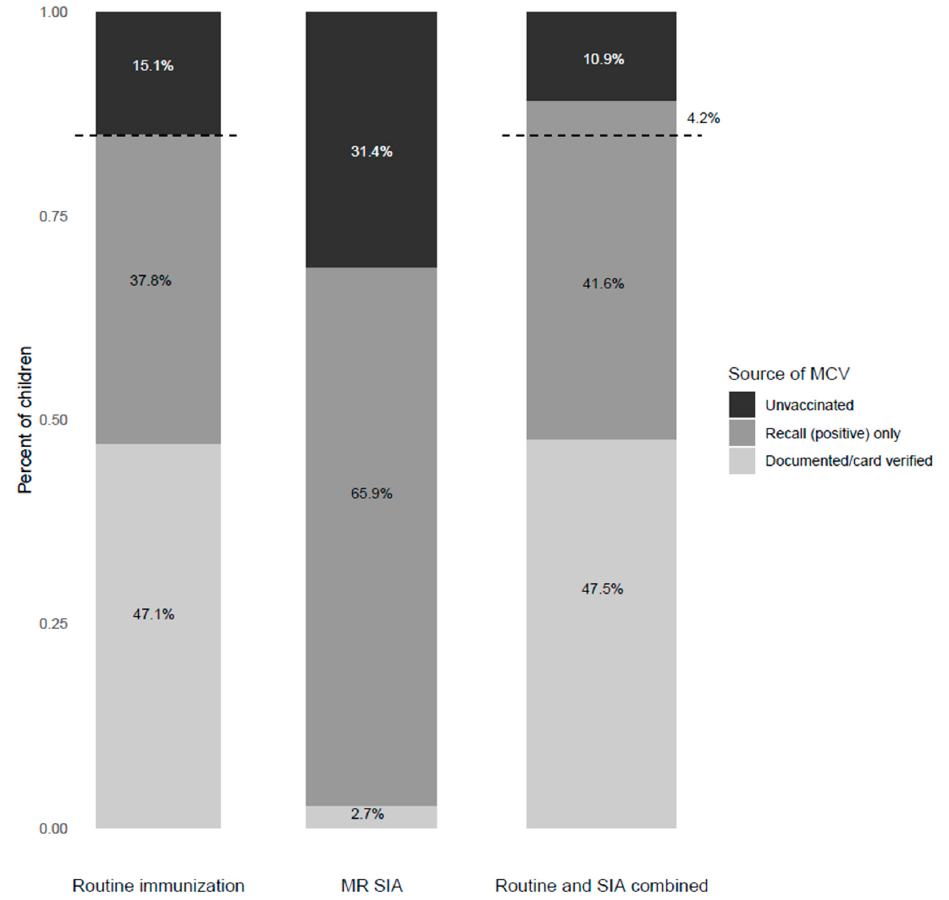
Figure 2. Measles and rubella vaccination coverage (at least one dose) among children between the ages of 9 and 59 months. The dashed line and percentage indicate the change in percentage of unvaccinated children before and after the MR-SIA.